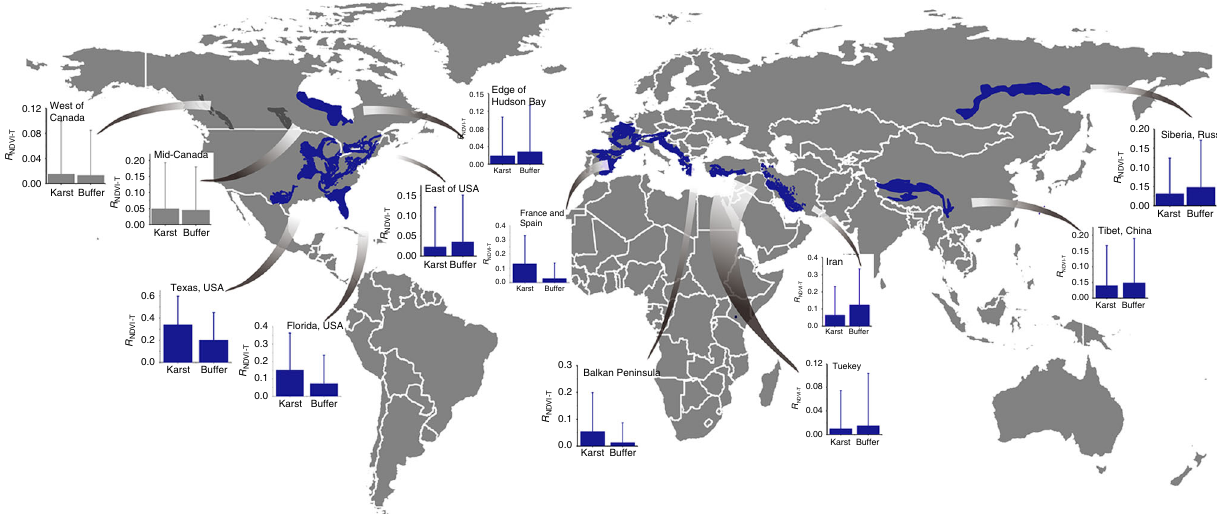
Fig. 5 Locations of the selected 12 largest karst regions. The selected karst regions are located at mid-latitudes (i.e., 30° to 60°N) in the Northern Hemisphere. The dark gray, and blue parts are the carbonate rock areas. The relationship between the NDVI and the growth season (April – September) mean temperature ( R NDVI-T ) was calculated at the pixel level. Subsequently, the difference in R NDVI-T between the inner and outer areas of carbonate rock buffer zones (with a width of 50 km) using a Mann – Whitney Wilcoxon test. Bars represent means for each treatment and error bars are 95% con fi dence intervals of the mean. Blue graphs indicate that the R NDVI-T value in the inner carbonate rock area is signi fi cant different with the outer area, dark gray graphs indicate that there are non-signi fi cant difference in R NDVI-T between both